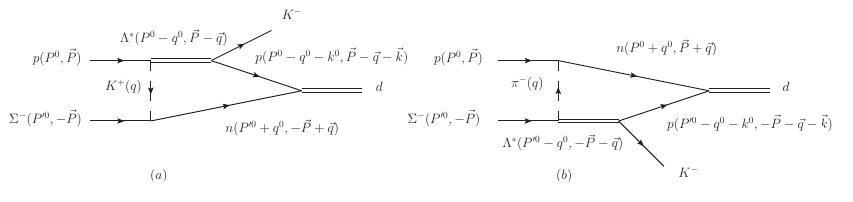
Figure 1. Feynman diagrams for the p Σ − → K − d reaction. The momenta of the lines are shown in brackets. Here, Λ ∗ stands for Λ